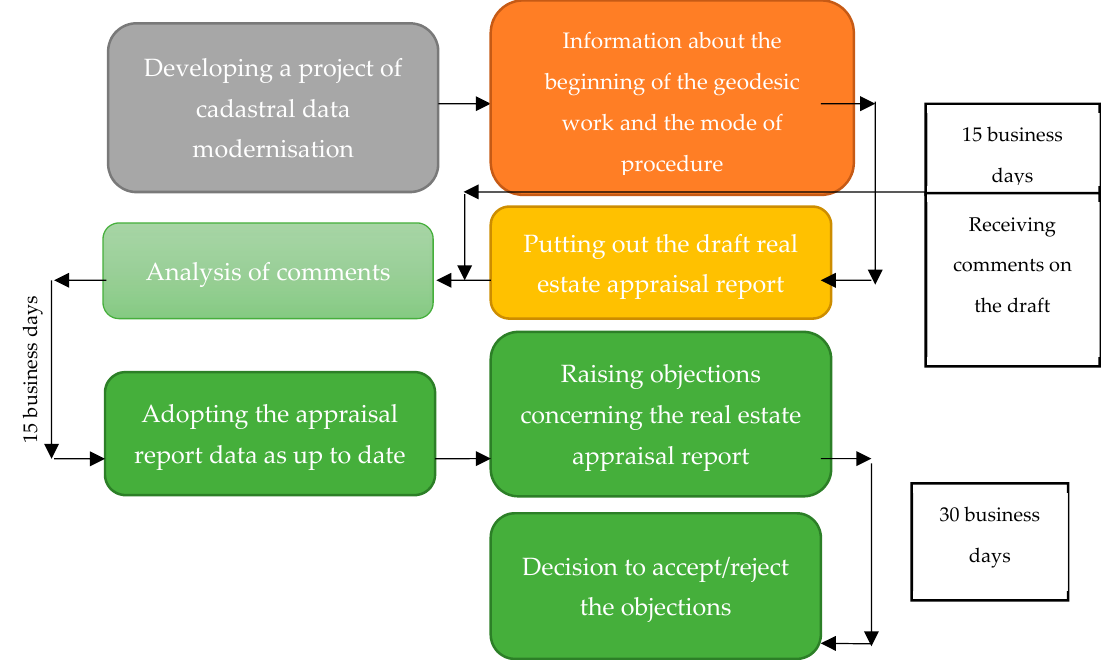
Figure 1. Stages of an administrative procedure of cadastral data modernisation. Periodical data verification (c) involves an examination of data consistency with the source documents on which an entry in the database is based and the consistency of the cadastral map with the situation in the field. The data consistency should be confirmed at least once every 10 years in each precinct (a division unit for the cadastral purposes) and it should cover at least 10% of source documents, on which the changes are based [28]. The consistency of a cadastral map with the actual state is checked at least once every 15 years and it covers the whole precinct (village). If considerable irregularities are revealed by the verification, the starost may order all data within the precinct (village) to be